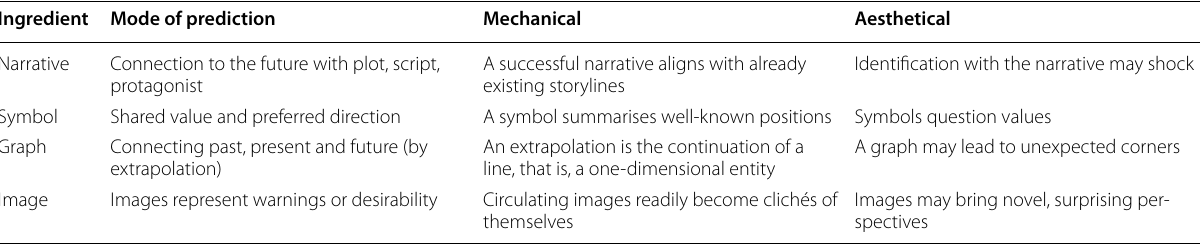
Table 4 Ingredients of produced futures studies Ingredient Mode of